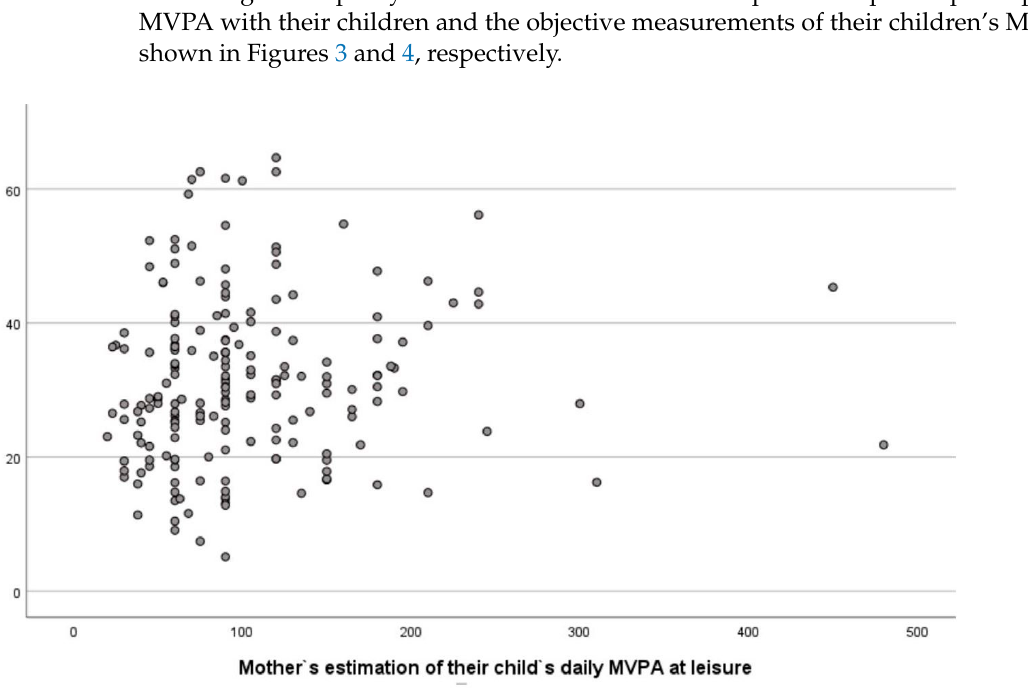
Table 3. Pearson correlations between parents’ estimation of their children’s PA level at leisure time and the children’s objectively-measured PA level at leisure time.